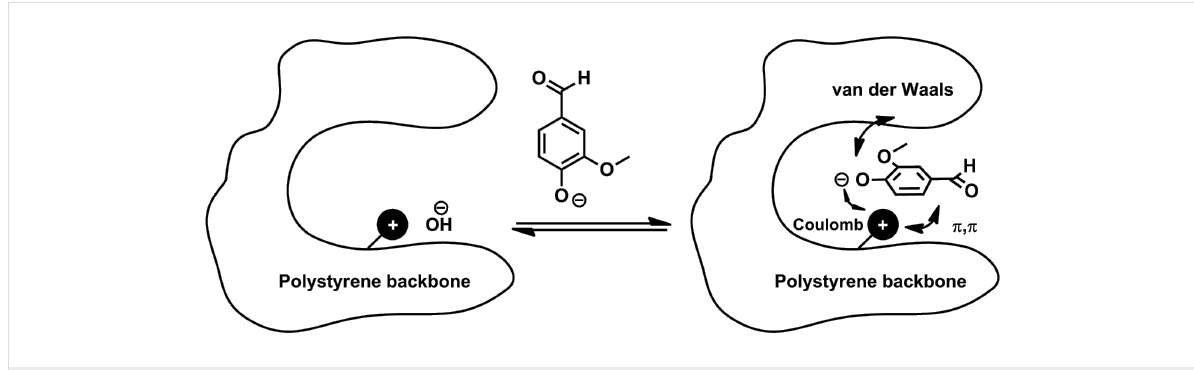
Figure 7: Different attractive interactions between ion exchange resin and the vanillate anion.